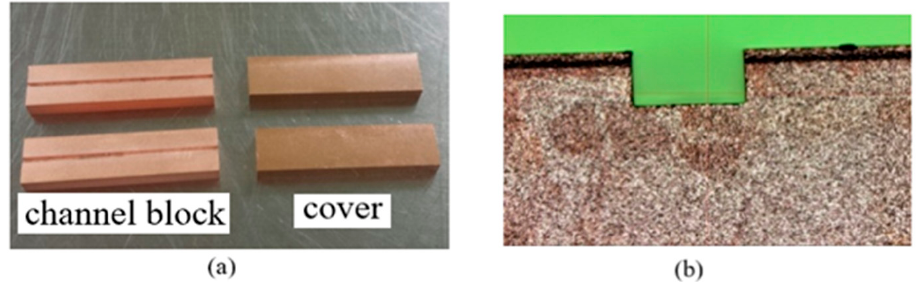
Figure 9. ( a ) Copper channel blocks and corresponding covers. ( b ) Cross ‐ section of the channel.